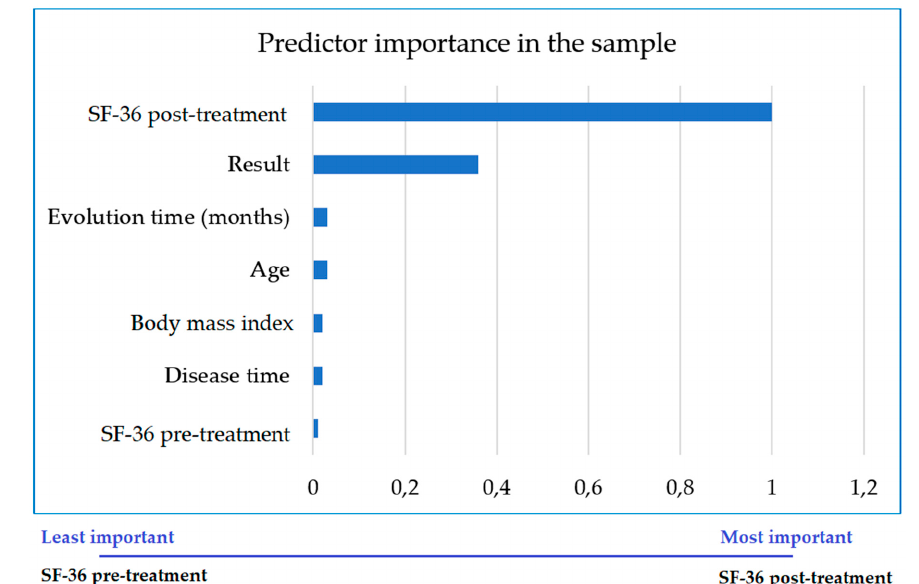
Figure 1. Importance of each variable as a predictor of the successful outcome of treatment in improving quality of life in all patients.